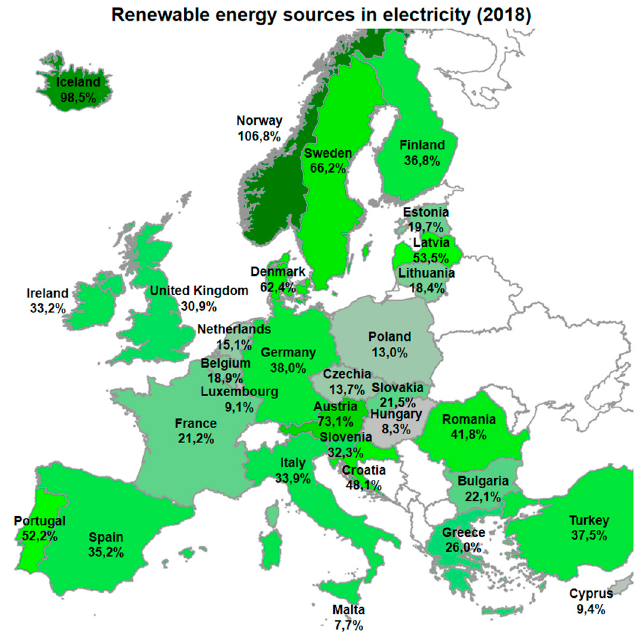
Figure 1. Share of renewable sources in electricity production in 2018 in selected European countries. Source: author’s study based on Eurostat databases. Table 1. Structure of obtaining energy from renewable sources in Poland by carriers 2014-2018. Renewable